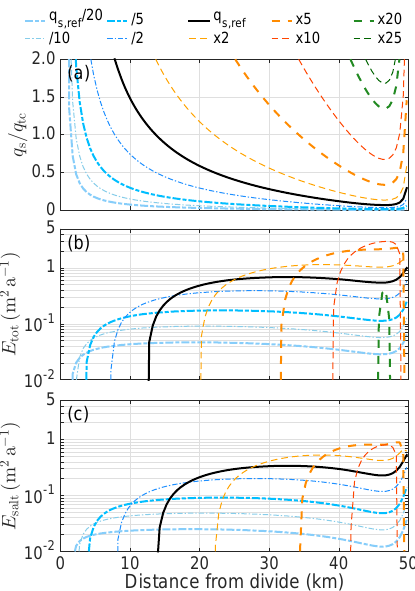
Figure 4. Influence of sediment supply rate q s (S_SSP, Table 3) on total erosion with the TLEM and SEM for the same hydrology as the reference simulation (S_REF, Table 3). The legend applies to all panels. (a) Relative sediment supply ( q s /q tc ), (b) total erosion rate computed with the TLEM ( E tot ), and (c) total erosion rate computed with the SEM ( E salt ). Note the logarithmic scale on the y axis of (b) and (c)